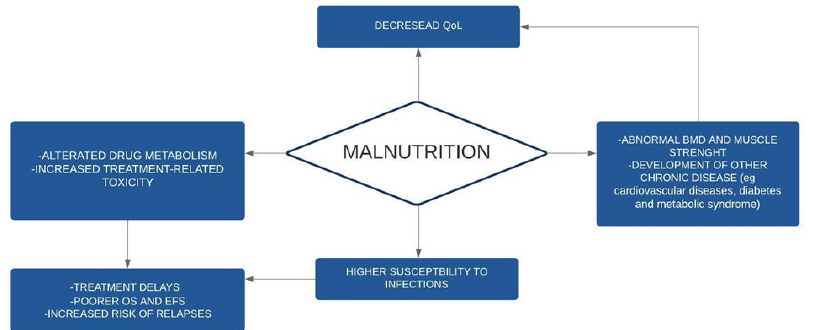
Figure 2. Consequences of malnutrition in children with cancer. BMD: bone mineral density; EFS: event-free-survival; OS: overall survival; QoL: quality of life.